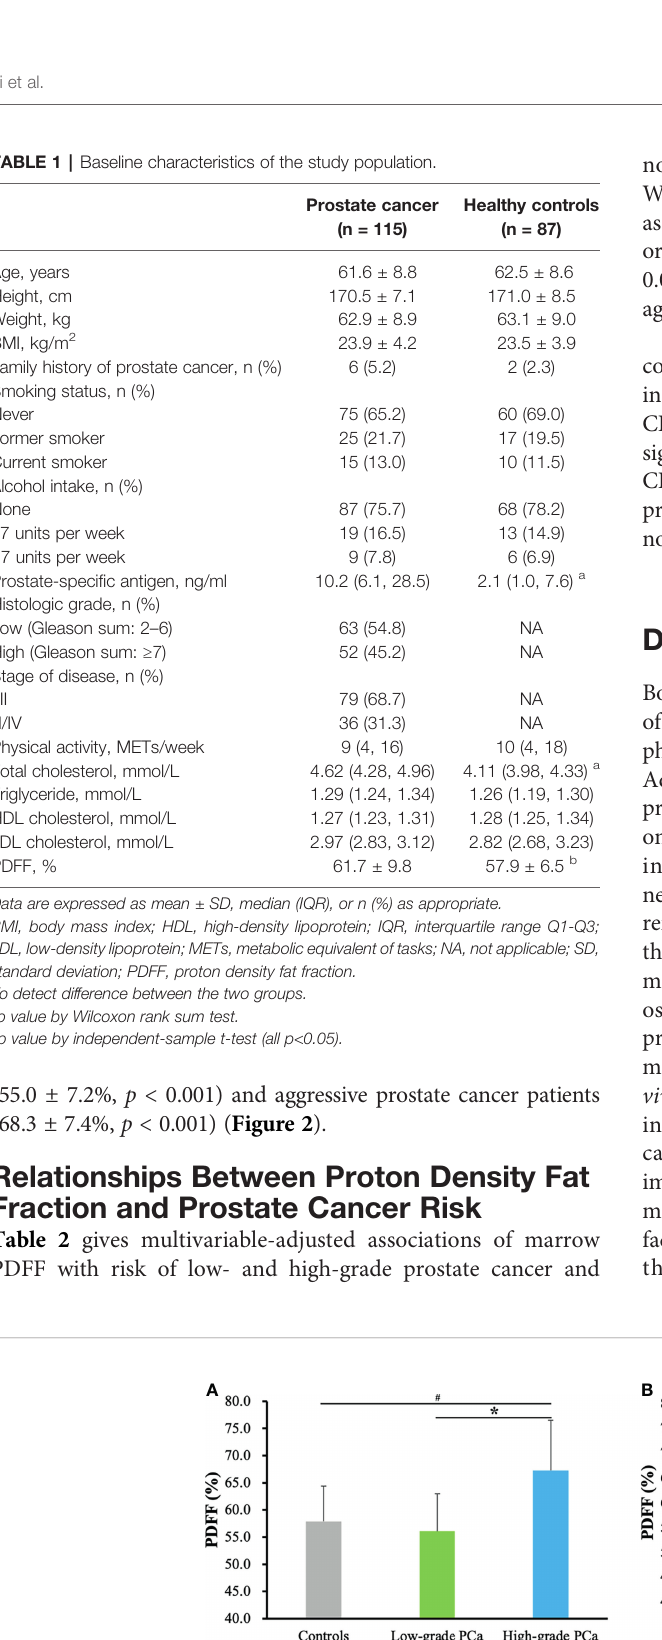
FIGURE 2 | Marrow PDFF results from the healthy controls, low- and high-grade prostate cancer (A) , and aggressive and non-aggressive prostate cancer (B) . Data are expressed as mean ± SD. # p < 0.001 and * p < 0.001 were calculated by ANCOVA followed by Bonferroni post-hoc multiple comparisons after adjusting for age, body mass index, alcohol intake, smoking status, physical activity, prostate speci fi c antigen levels, levels of blood lipids, and family history of prostate cancer. PCa, prostate cancer; PDFF, proton density fat